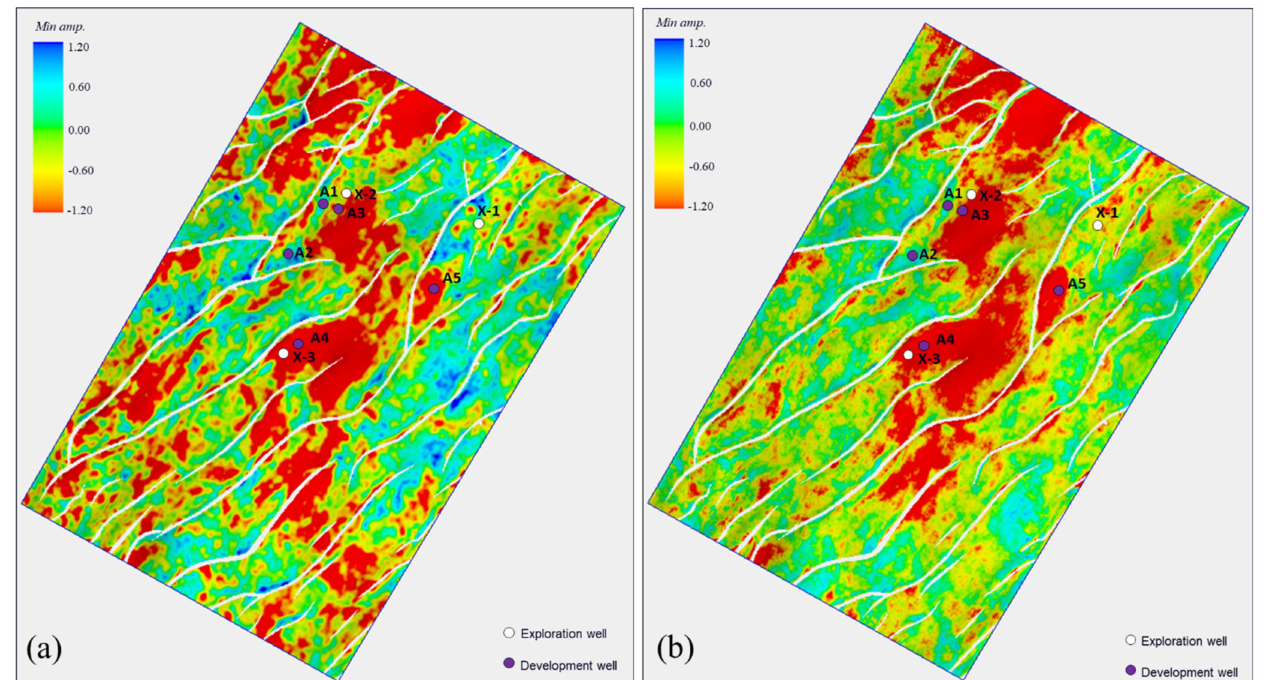
Figure 10. Minimum amplitude attribute of the P4 layer in the study area: ( a ) the minimum am- plitude of post-stack seismic analysis; ( b ) the minimum amplitude of far-offset partial stacked seismic analysis.